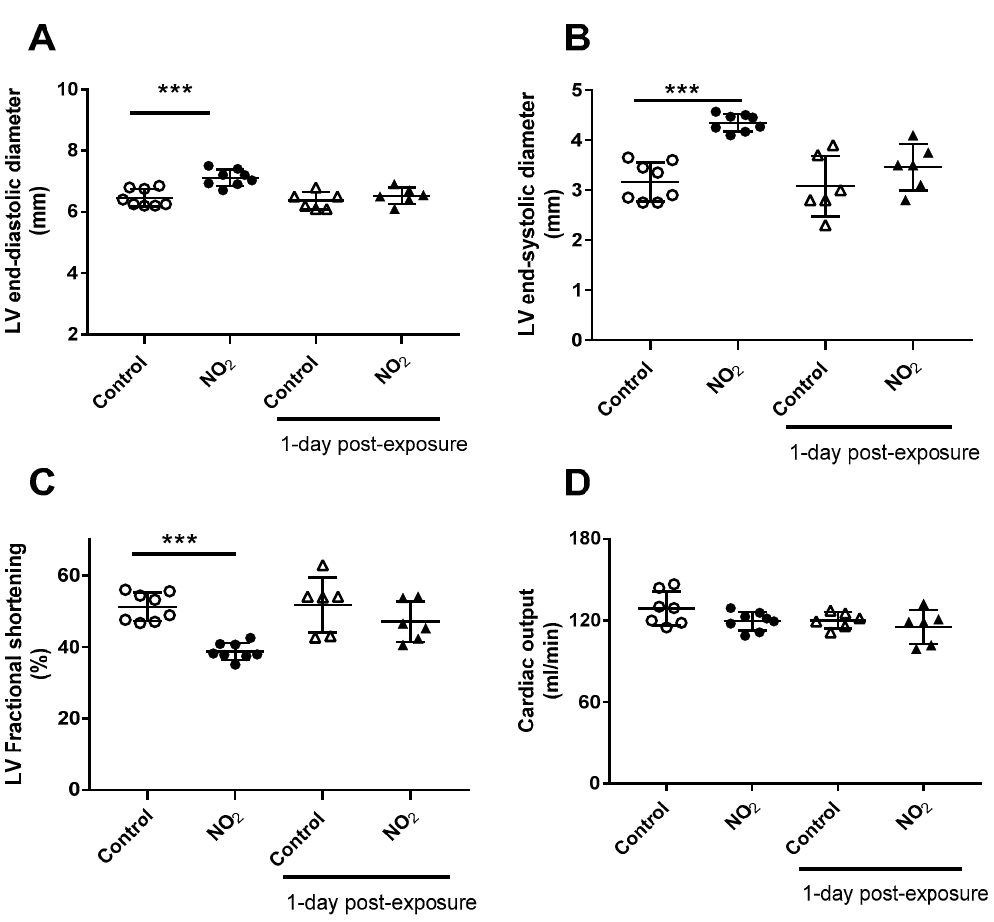
Figure 2. Echocardiographic parameters and endothelial function after acute NO 2 exposure. The diagram shows echocardiographic measurements of left ventricle (LV) end-diastolic diameter ( A ), LV end-systolic diameter ( B ), LV fractional shortening ( C ) and cardiac output ( D ), measured after acute NO 2 exposure or 1-day post-exposure when specified. *** p < 0.001 between corresponding group.